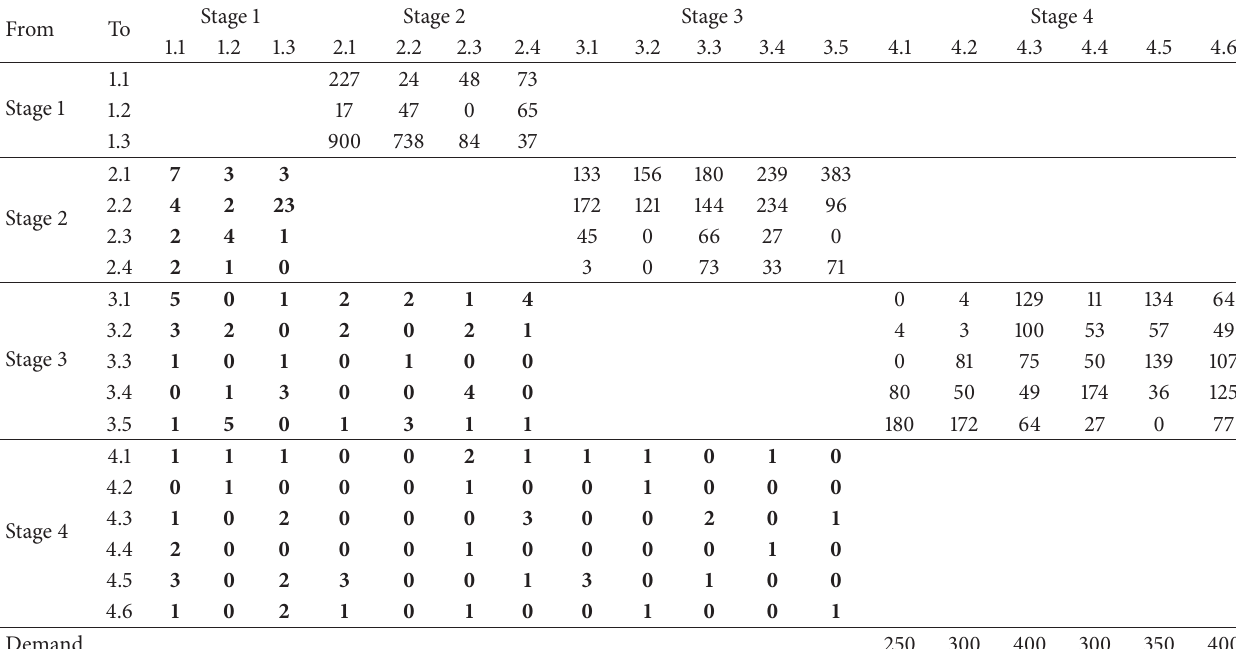
Table 15: The third period transportation plan by PSOA